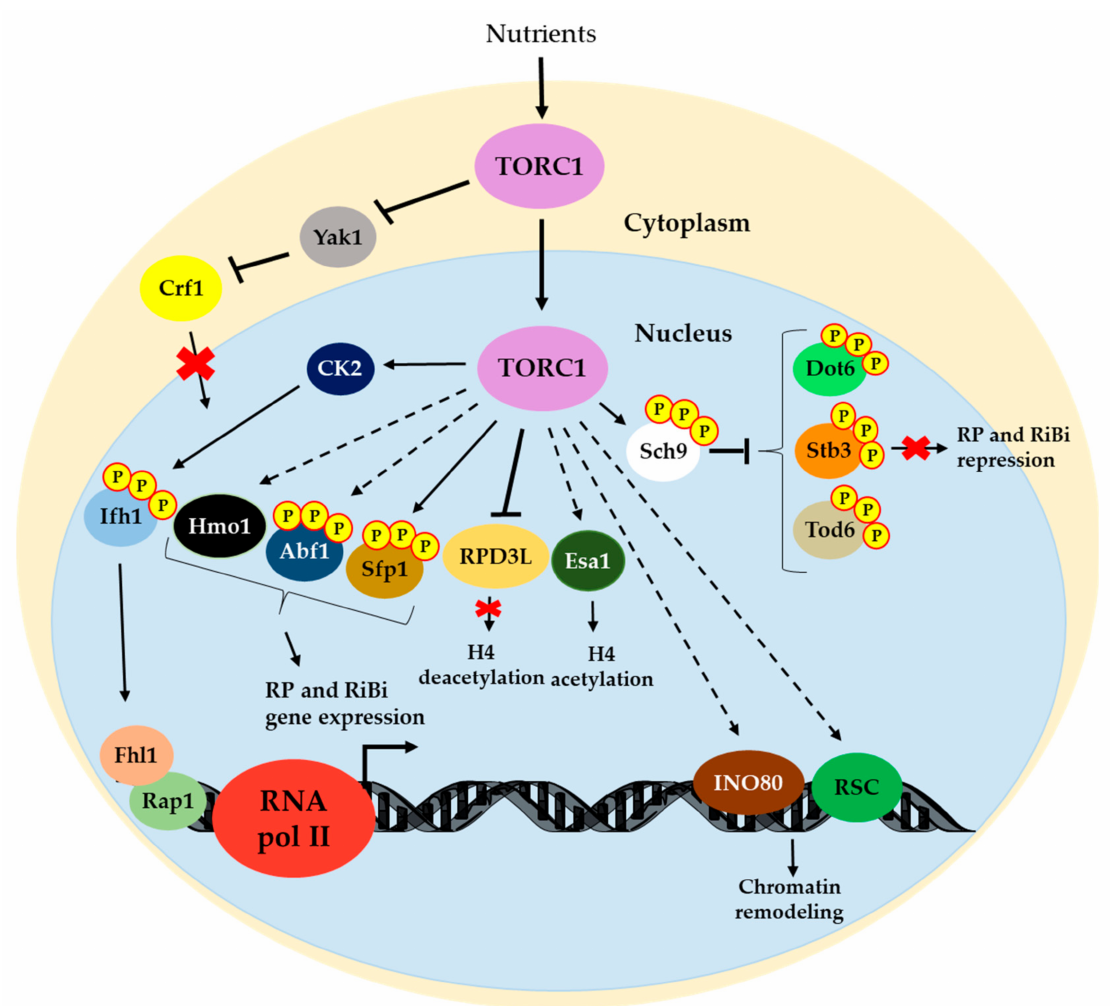
Figure 2. Regulatory network from TORC1 to RP and RiBi genes. TORC1 promotes RP and RiBi gene expression by maintaining the Crf1 corepressor in the cytoplasm (through Yak1 kinase) by avoiding its interaction with the Rap1/Fhl1 complex [75]. Ifh1 is phosphorylated by CK2 (downstream effector of TOR) to allow its interaction with Rap1/Fhl1 and to drive RP and RiBi gene expression [76,77]. TORC1 directly phosphorylates Sfp1 by promoting RiBi and a set of RP genes expression [81]. Abf1 could modulate some RP and RiBi genes in a TOR-dependent manner [84,85]. Hmo1 activity on RP gene expression is also modulated by TOR [51]. TORC1 also contributes to RP and RiBi gene expression by phosphorylating Sch9 that, in turn, phosphorylates repressors Dot6, Tod6 and Stb3 [89,90]. Finally, TORC1 could regulate histone modification (positively through Esa1 [95] and negatively through RPD3L [91]) and chromatin remodeling (through RSC [93] and INO80 [94]) to promote RNA pol II transcription. As Figure 1 depicts, solid lines indicate direct positive regulation. Dotted lines denote indirect positive regulation. Bars refer to negative regulation. Details for each mechanism are provided in the